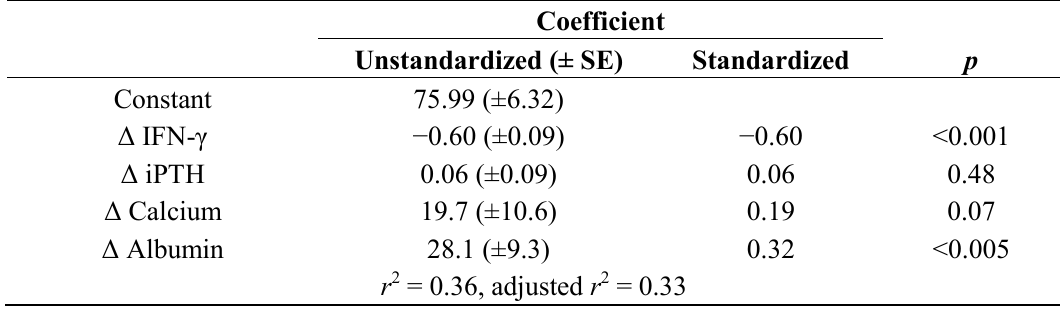
Table 2. Circulating albumin increases predict serum 25(OH)D increases, while IFN-γ increases predict serum 25(OH)D